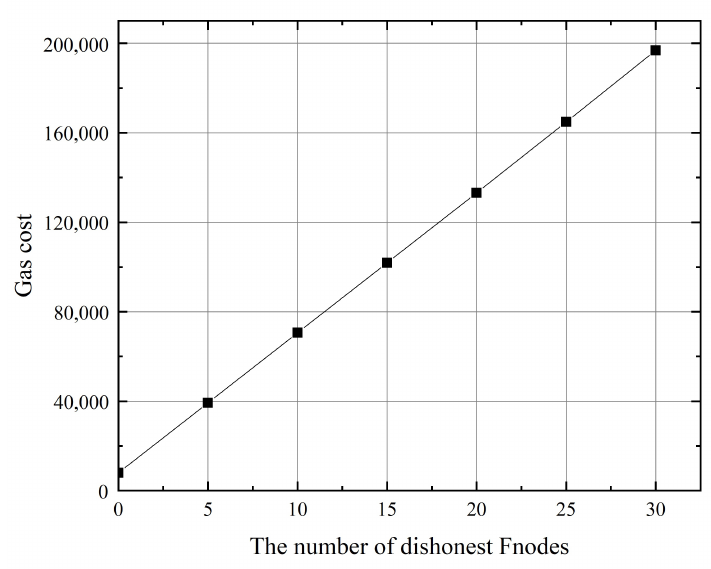
Figure 14. Gas cost of the authority recording the report result and the dishonest Fnode